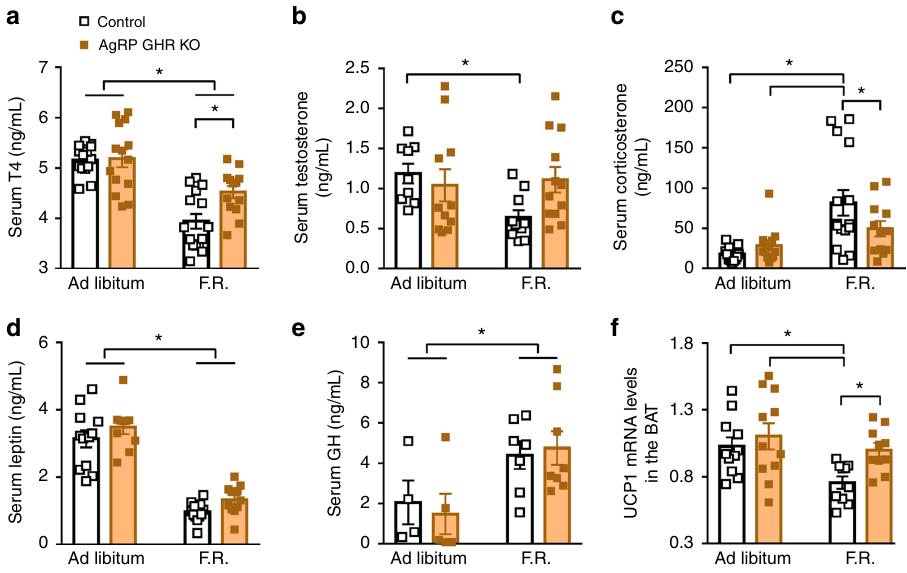
Fig. 3 Neuroendocrine changes induced by weight loss are attenuated in agouti-related protein (AgRP) growth hormone receptor knockout (GHR KO) mice. a Serum concentration of T4 (main effect of food restriction (F.R.) [ F (1,53) = 46.18, P < 0.0001], main effect of GHR ablation [ F (1,53) = 2.796, P = 0.1004] and interaction [ F (1,53) = 4.953, P = 0.0303]). b Serum concentration of testosterone (main effect of F.R. [ F (1,38) = 2.36, P = 0.1327], main effect of GHR ablation [ F (1,38) = 1.086, P = 0.3039] and interaction [ F (1,38) = 3.949, P = 0.0541]). c Serum concentration of corticosterone (main effect of F.R. [ F (1,49) = 16.13, P = 0.0002], main effect of GHR ablation [ F (1,49) = 1.072, P = 0.3055] and interaction [ F (1,49) = 4.13, P = 0.0476]). d Serum concentration of leptin (main effect of F.R. [ F (1,41) = 140.3, P < 0.0001], main effect of GHR ablation [ F (1,41) = 3.803, P = 0.058] and